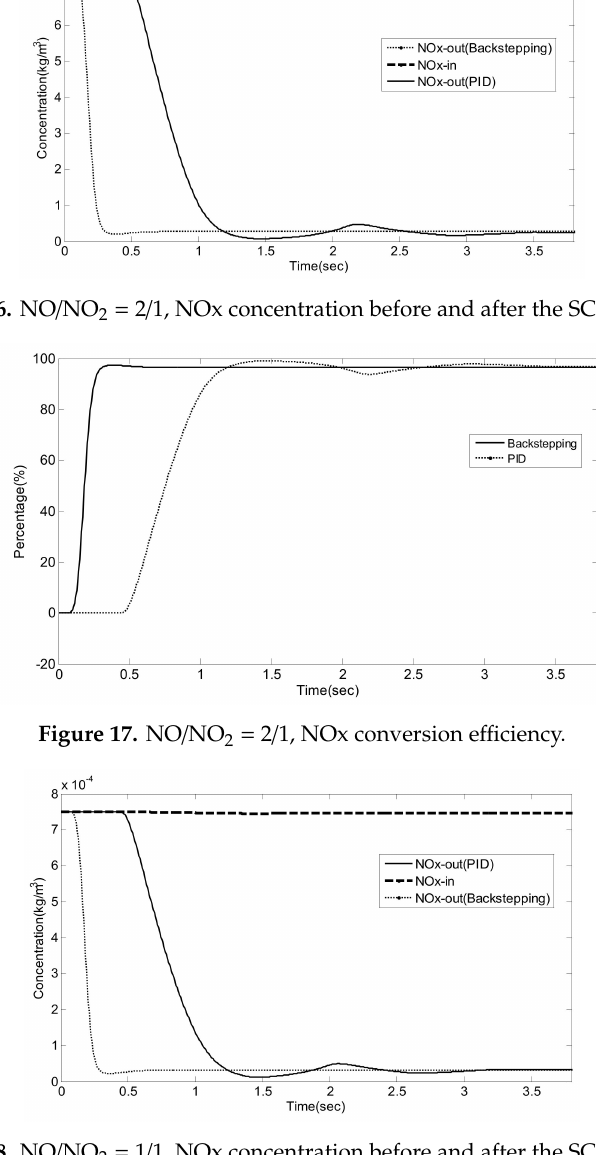
Figure 18. NO / NO 2 = 1 / 1, NOx concentration before and after the SCR